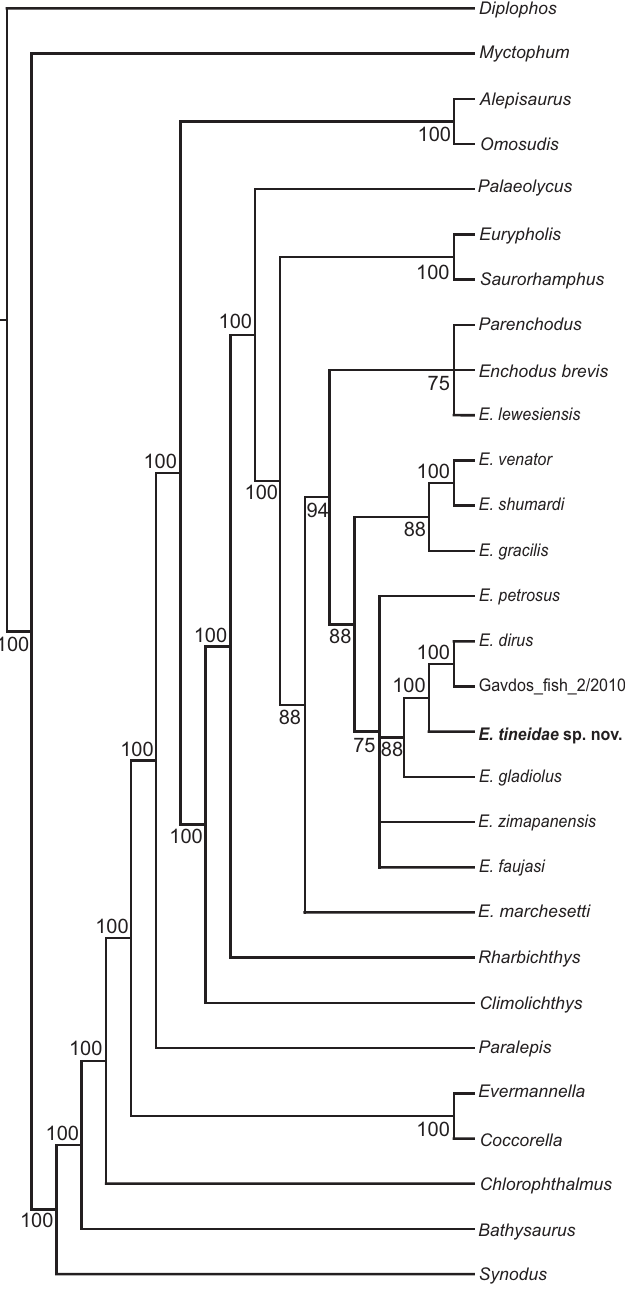
Fig. 4. Majority rule consensus of 222 equally parsimonious trees (TL = 263, CI = 0.53, HI = 0.47, RI = 0.75, and RC = 0.4). Numbers next to branches indicate the percentage of trees in which each clade is